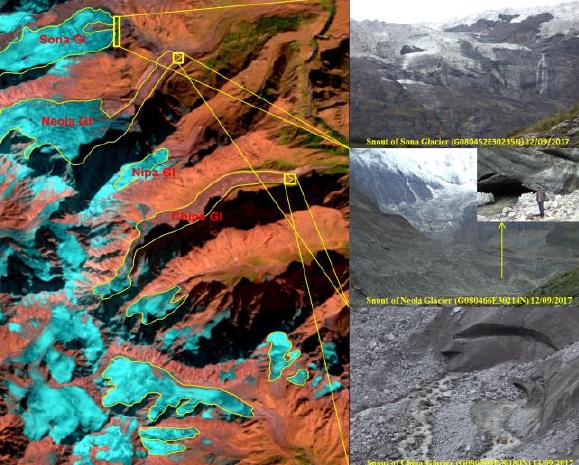
Figure 5. Map showing snout positions of Sona, Neola and Chipa glacier, photographs by Dhanendra Kr. Singh